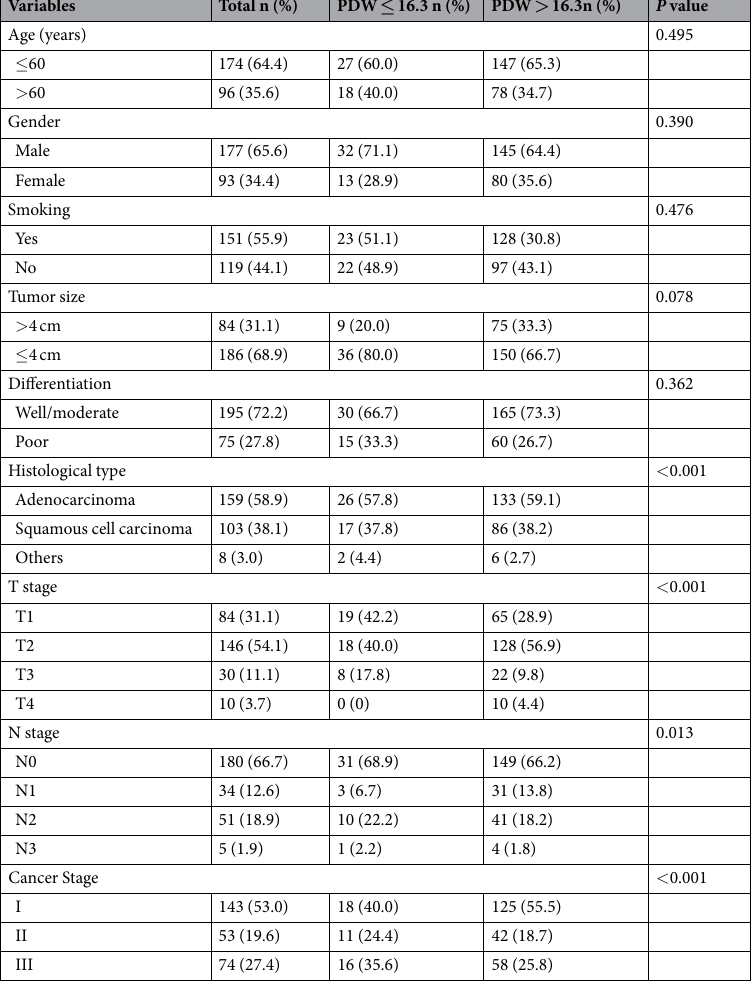
Table 1. Baseline characteristics of the patients with lung cancer according to PDW levels. PDW, platelet distribution